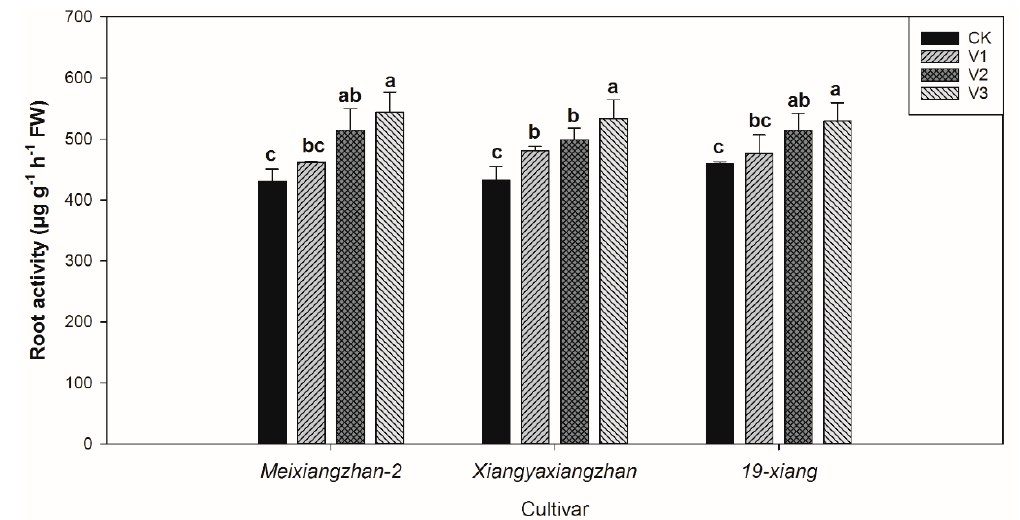
Figure 3. Effects of vermicompost incorporation on root activity of fragrant rice seedlings; those sharing a common letter do not differ significantly at p < 0.05 according to the least significant difference (LSD) test for three fragrant rice cultivars.